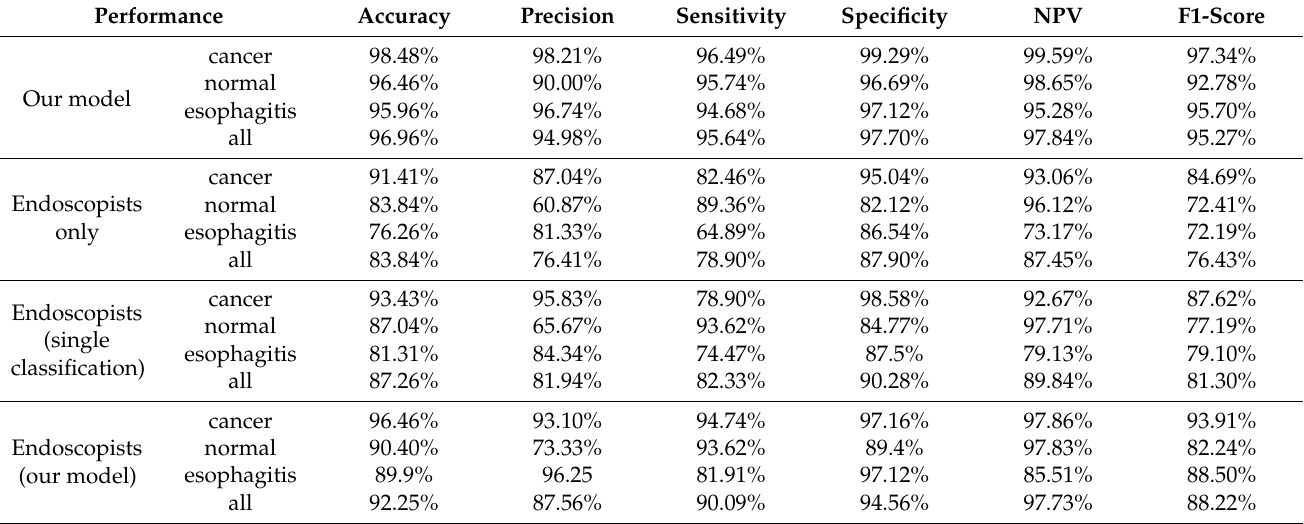
Table 4. The diagnostic performance of the endoscopists without and with the proposed